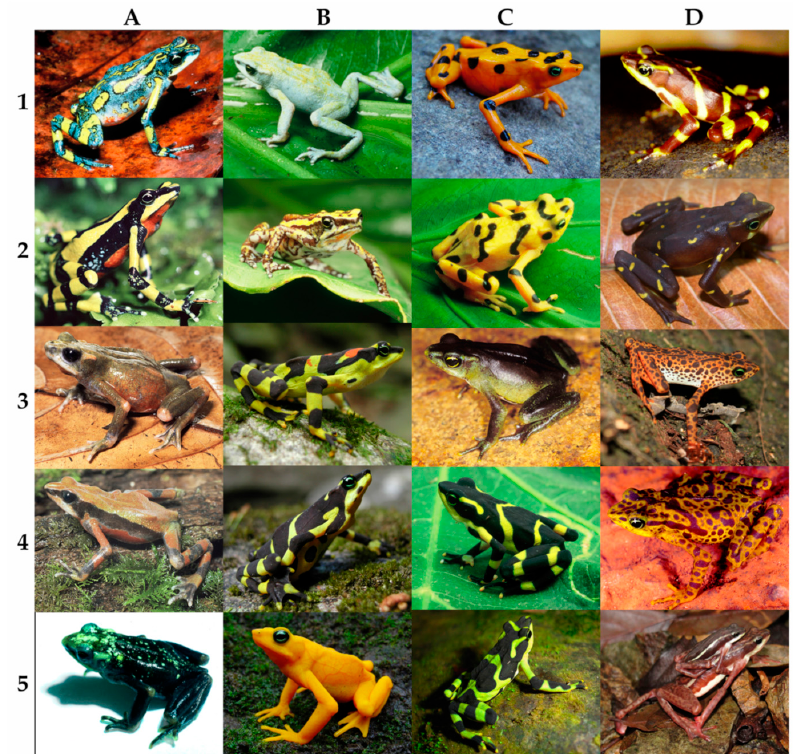
Figure 4. Geographic color pattern variation of some harlequin frogs from central to eastern Panama and adjacent Colombia. Rows are arranged from west ( 1 ) to east ( 5 ) for columns ( A – C ), and north ( 1 ) to south ( 5 ) for column ( D ). Columns represent regions from Central America to Colombia: ( A ) Costa Rica; ( B ) western to central Panama; ( C ) central to eastern Panama and adjacent Colombia; ( D ) eastern Panama and Darién Province, Panama ( 1 – 4 ) to adjacent Colombia ( 5 ). Unscaled photographic images of: ( A1 , A2 ) Atelopus sp. “Monteverde” from the Monteverde Cloud Forest Reserve, Punta Arenas- Alajuela Provinces, Costa Rica (Figure 1, locality 12); ( A3 ) male and ( A4 ) female Atelopus senex from